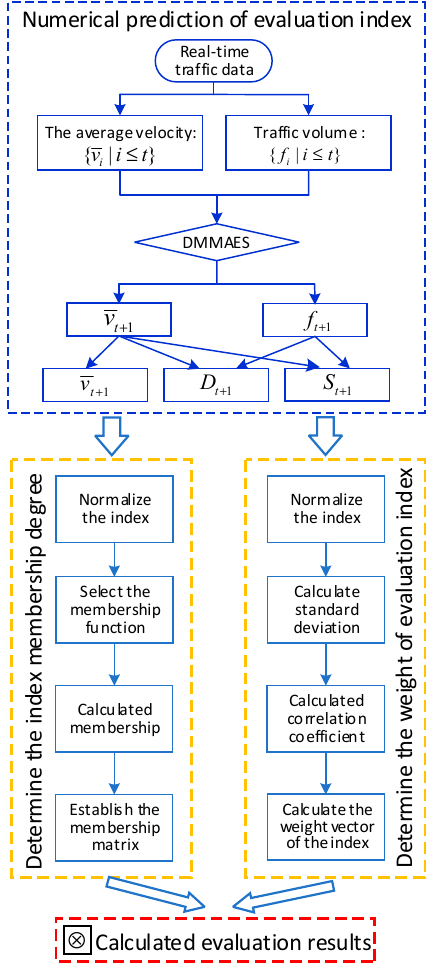
Figure 2. Traffic congestion situation assessment (TCSA) scheme.